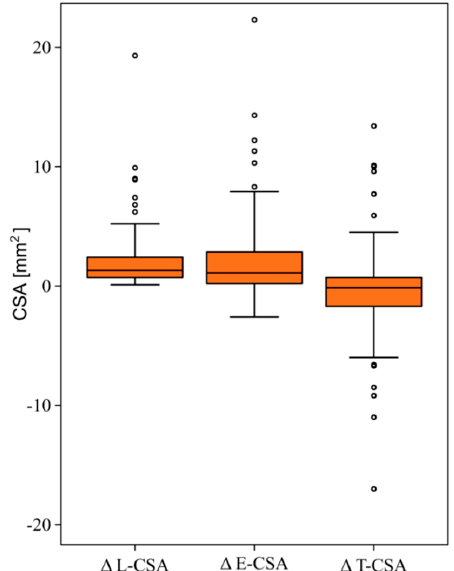
Figure 3. Distribution of changes in cross-sectional area (CSA) of the lumen, pulmonary artery stenosed segment and the organized thrombus after balloon pulmonary angioplasty. ( n = 98). Both L-CSA and the E-CSA increased ( Δ = 1.4(0.7–2.4) mm 2 ; p < 0.001 and Δ = 1.0(0.1–2.8) mm 2 ; p < 0.001), respectively). There was no change in the T-CSA ( Δ = − 0.1( − 1.3; 0.7) mm 2 ; p = 0.23). The lines and boxes represent medians and interquartile (IQR) ranges. The width of the whisker is calculated as a 2*IQR. The points represent values outside the range denoted by whiskers. Abbreviations: E-CSA—pulmonary artery stenosed segment cross-sectional area; L-CSA—lumen cross-sectional area; T-CSA—organized thrombus cross-sectional area.